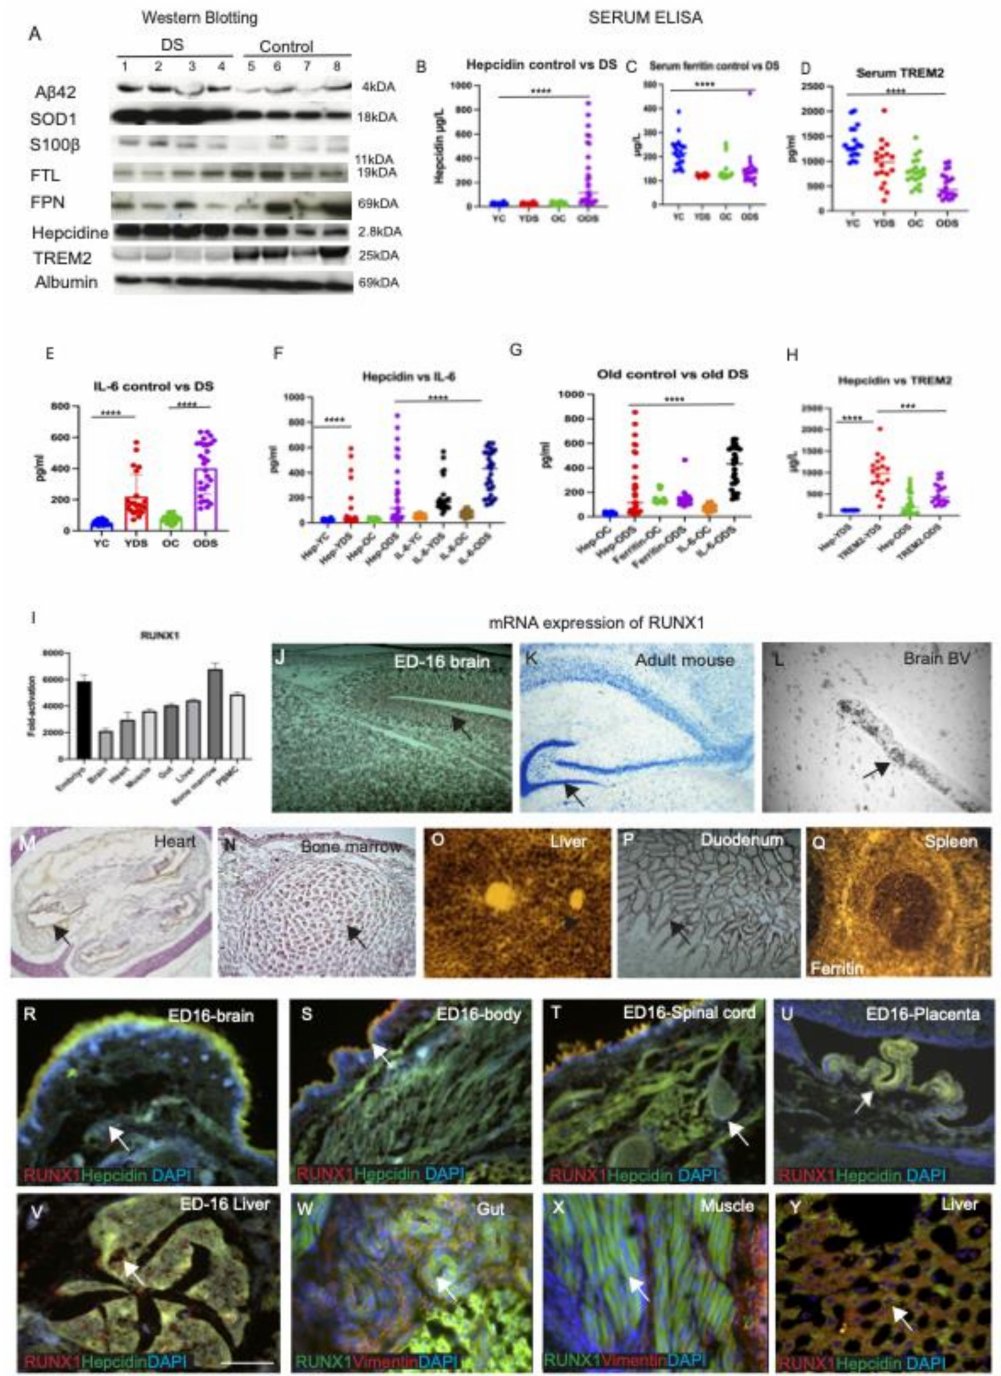
Figure 7. Serum hepcidin and IL-6 could be involved in host defence mechanism in DS brain. RUNX1 mRNA expression was higher in the liver, bone marrow and duodenal endothelial cells, as assessed by in situ hybridisation. To investigate the effect of trisomy-21-related proteins (A β 42, SOD1, S100 β ) and iron regulatory proteins (FTL, FPN, hepcidin), as well as inflammatory marker TREM2, on serum levels, a cohort of DS subjects ( n = 18) and age-matched controls ( n = 18) was